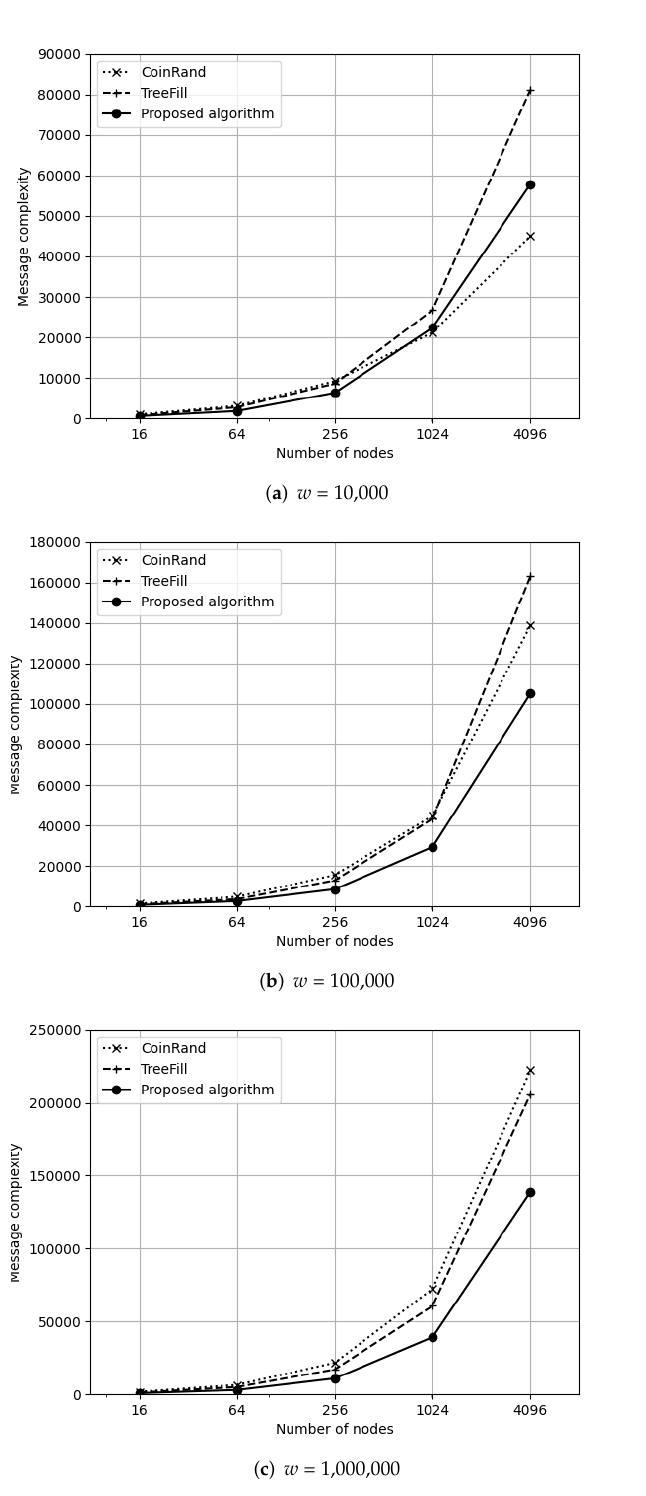
Figure 2. Comparison of message complexity between CoinRand , TreeFill , and the proposed algorithm when the number of nodes is 16, 64, 256, 1024, and